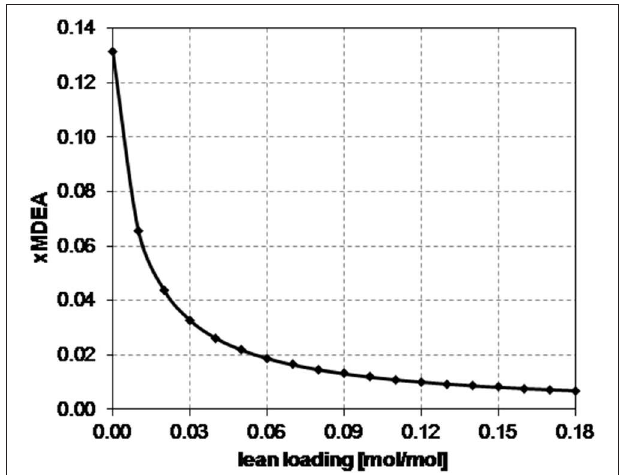
FIGURE 5 | Effect of the CO 2 lean loading on the mole fraction of MDEA in the